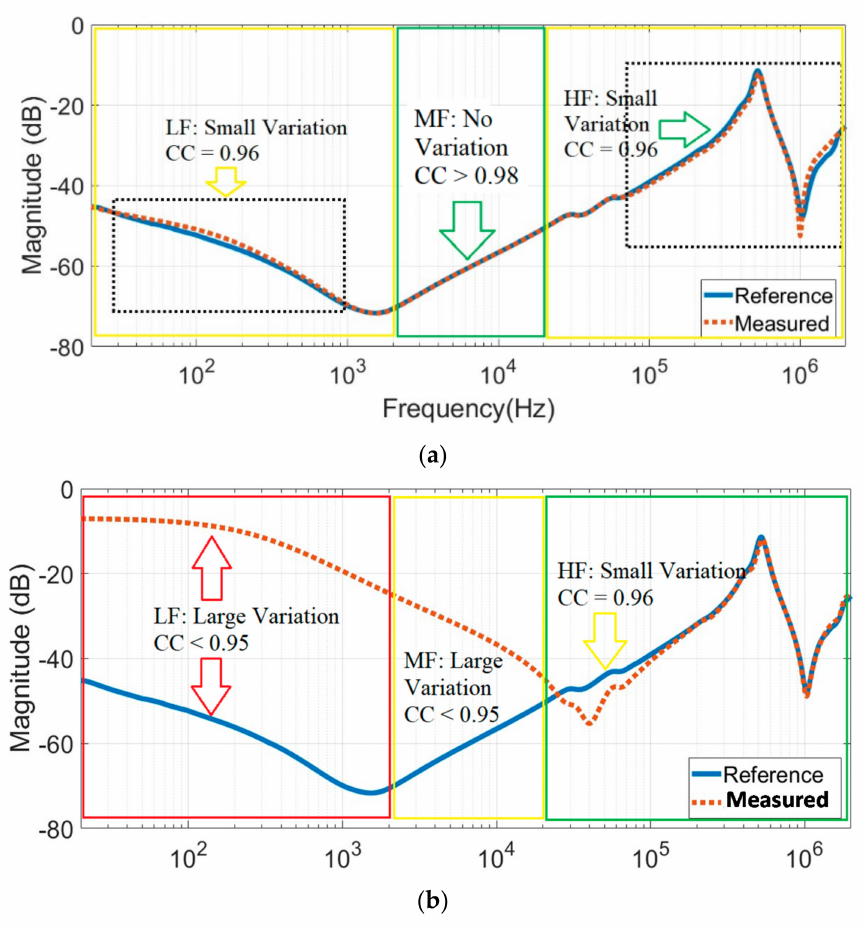
Figure 8. Example of variation between the measured and reference frequency responses: ( a ) small variation and ( b ) considerable or large variation.